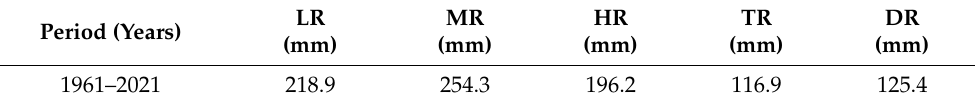
Table 2. The regionally averaged light rainfall (LR), moderate rainfall (MR), heavy rainfall (HR), torrential rainfall (TR), and downpour rainfall (DR) in the QMs during the period 1961–2021. Period